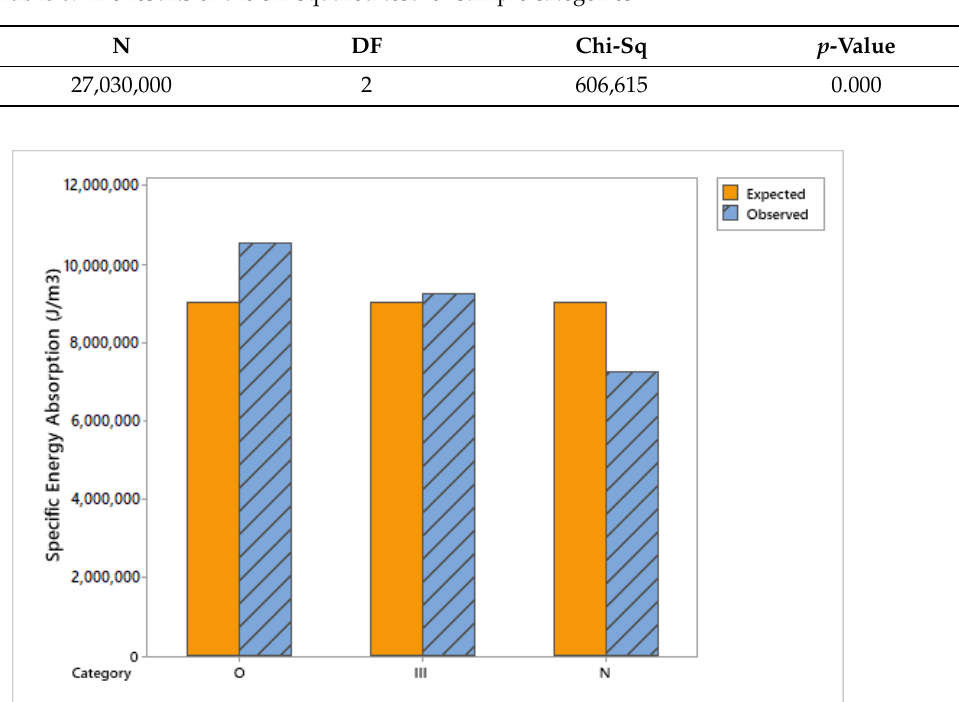
Figure 14. Observed vs. expected specific energy absorption mean values by sample categories. Processes 2021 , 9 , 315